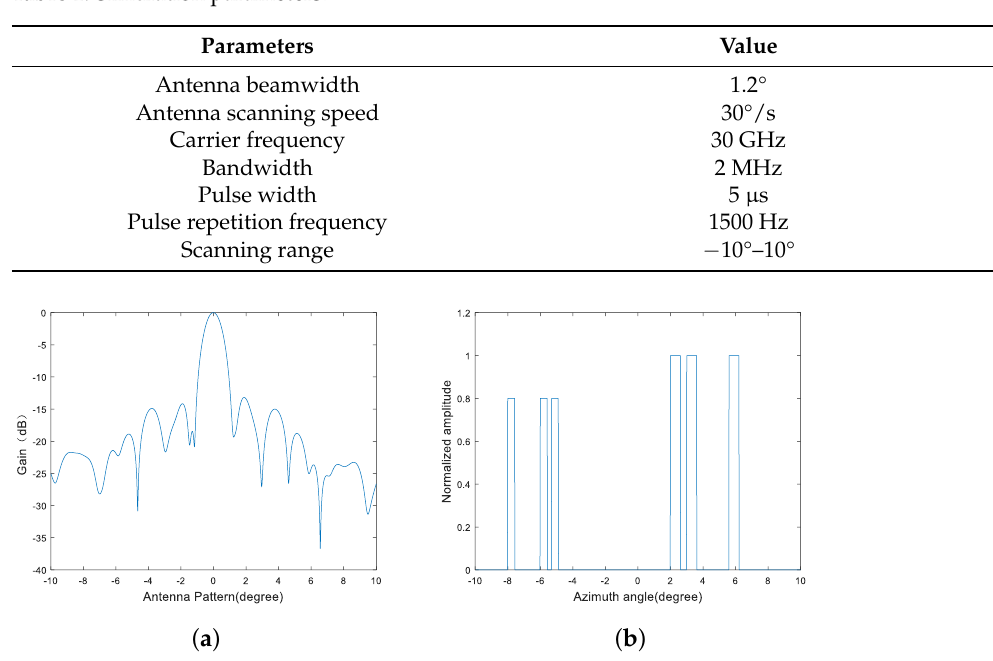
Table 1. Simulation parameters.